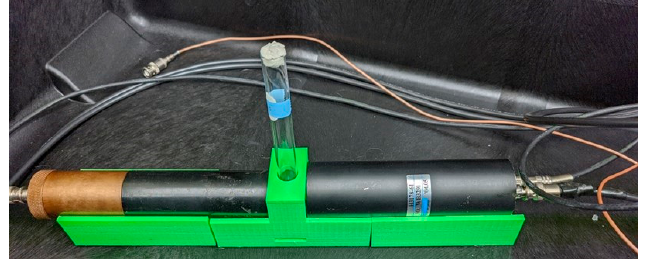
Figure 1. The experimental setup with two PMTs and a sample holder in a dark box.